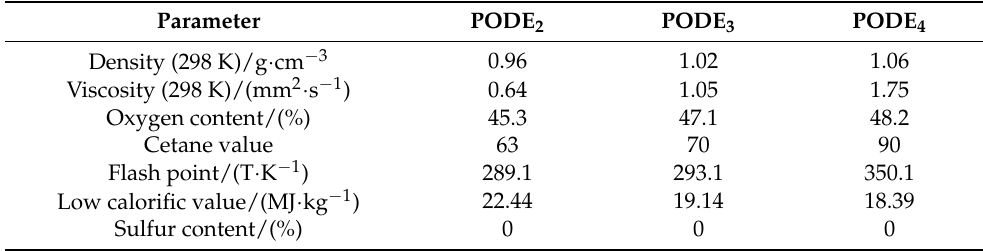
Table 3. Physical and chemical parameters of PODE n ( n = 2–4) [29,38–41].